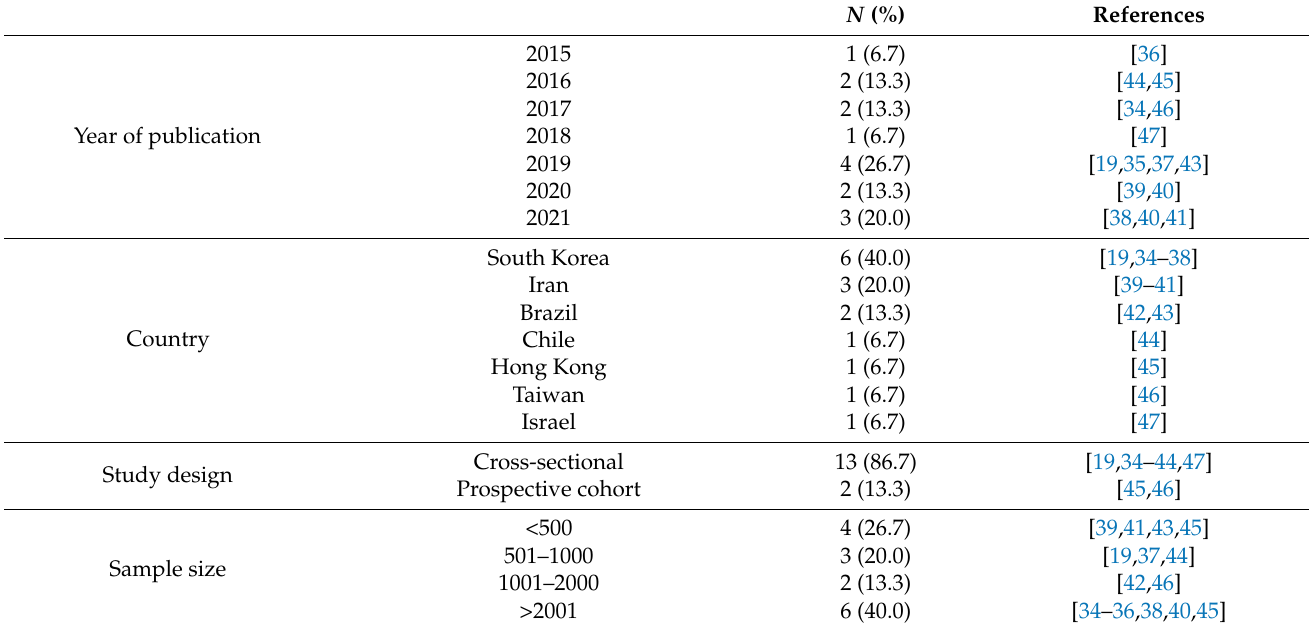
Table 1. Characteristics of studies included in the review ( n =15).